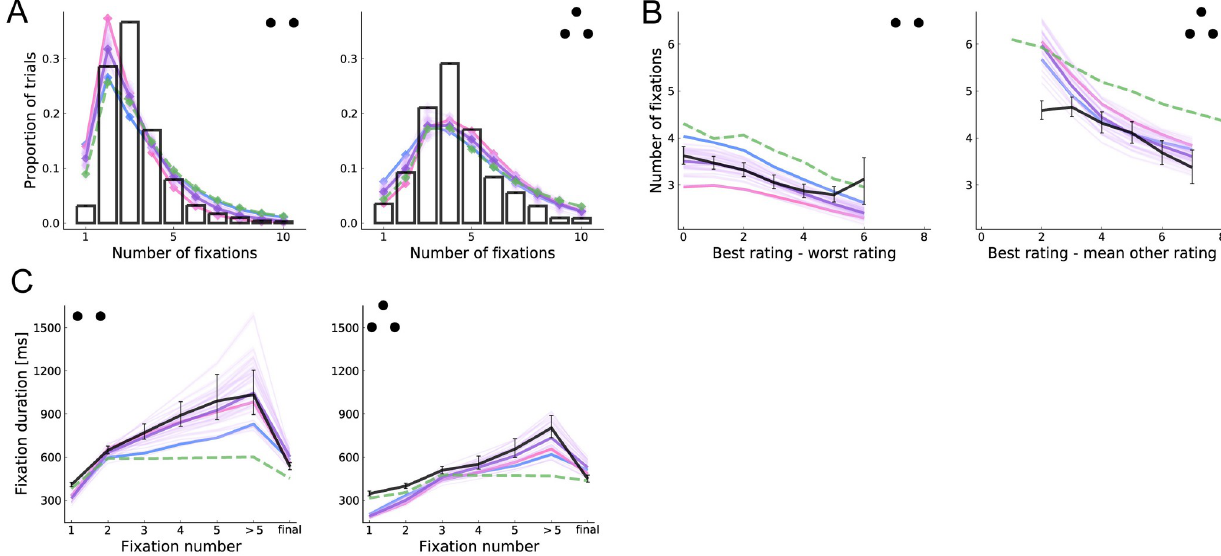
Fig 4. Basic fixation patterns. (A) Histogram of number of fixations in a trial. (B) Number of fixations as a function of decision difficulty, as measured by the relative rating of the best item. (C) Duration of fixation by fixation number. Final fixations are excluded from all but the last bin. See Fig 3 for more